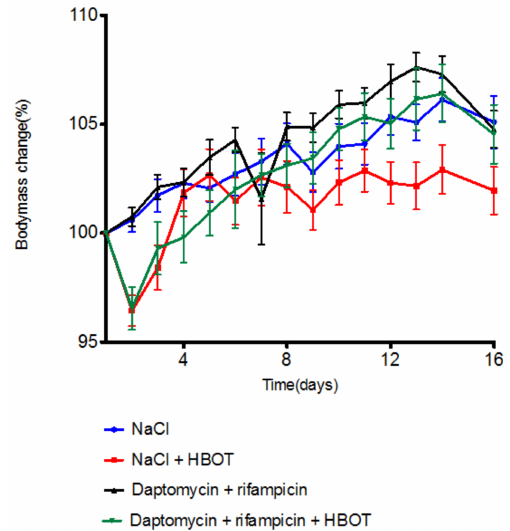
Figure 1. Mean mouse body mass ± standard deviation (SD) (% of body mass at day 1)